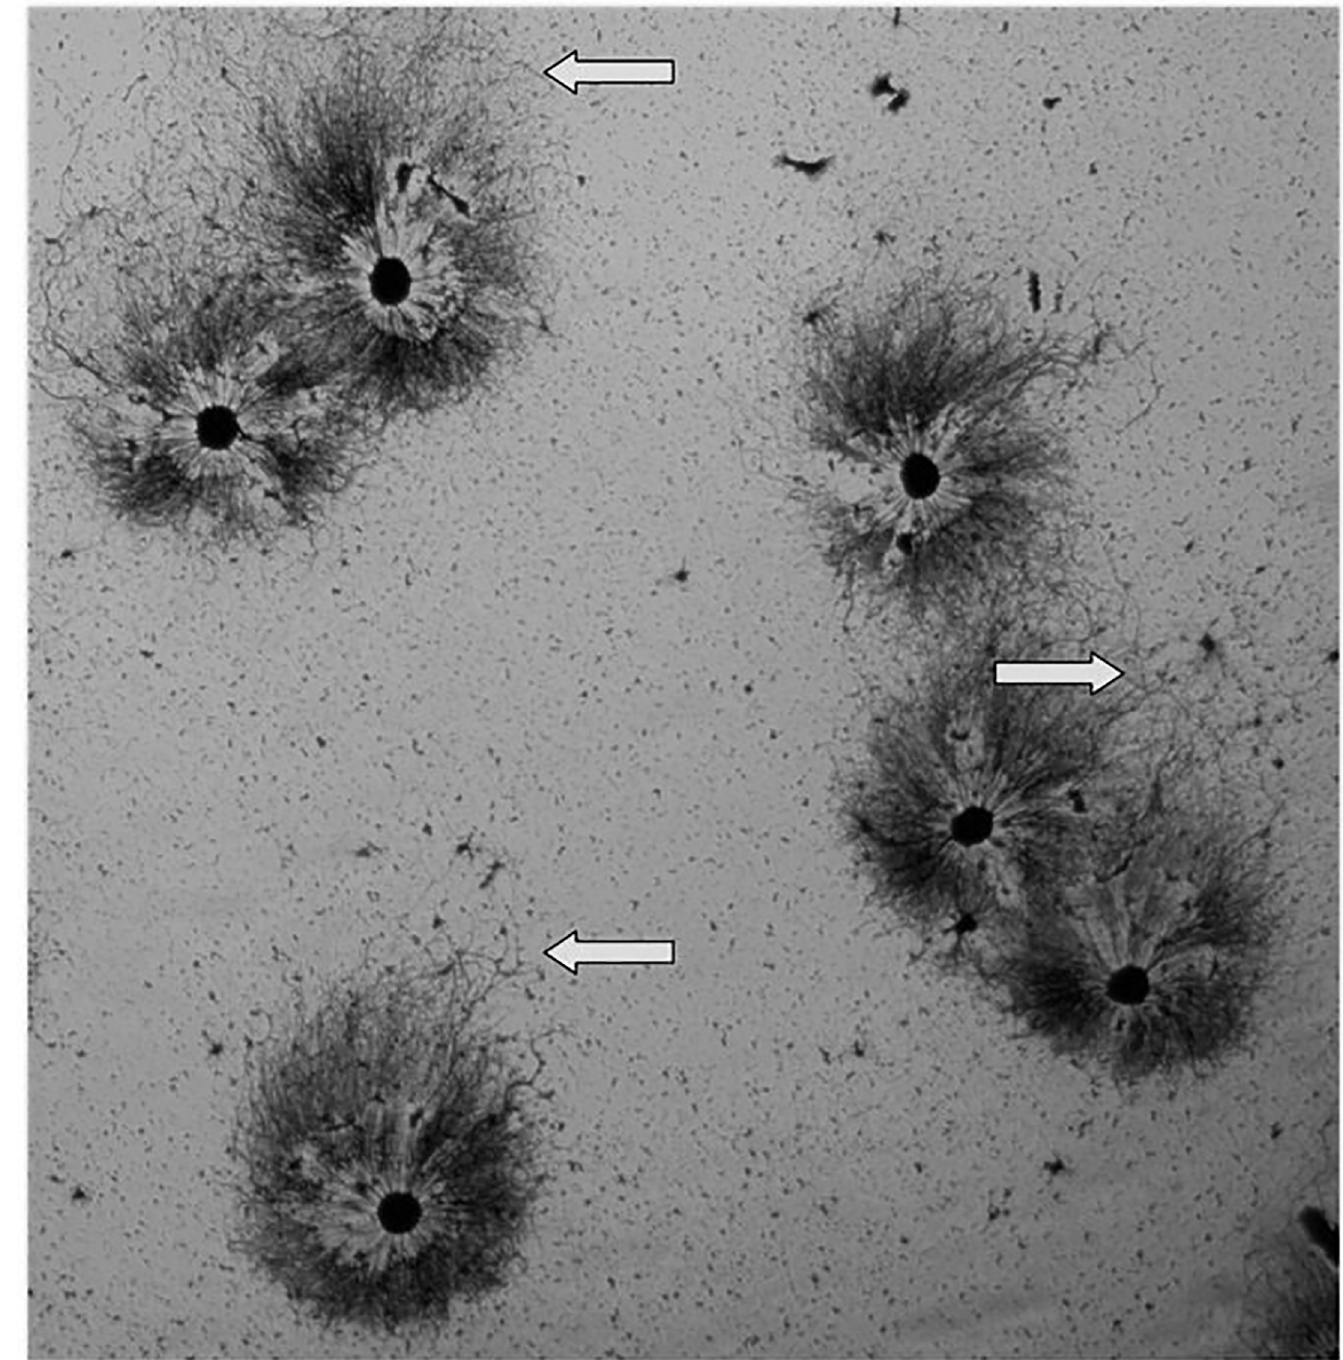
Fig 11. A field of “reaggregated” explants is shown stained with silver nitrate. The ganglia were first dissociated, and the cells were then allowed to form clusters before plating. The resulting neurite halos exhibit asymmetry and the longest neurites extend in the same general direction [towards the top of the field, as indicated by the arrows]. The neurites on the opposite side of each halo tend to be shorter and to establish a sharper boundary.